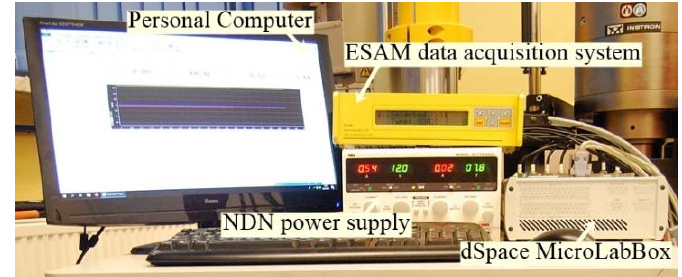
Figure 6. Bolt forces measurement set.